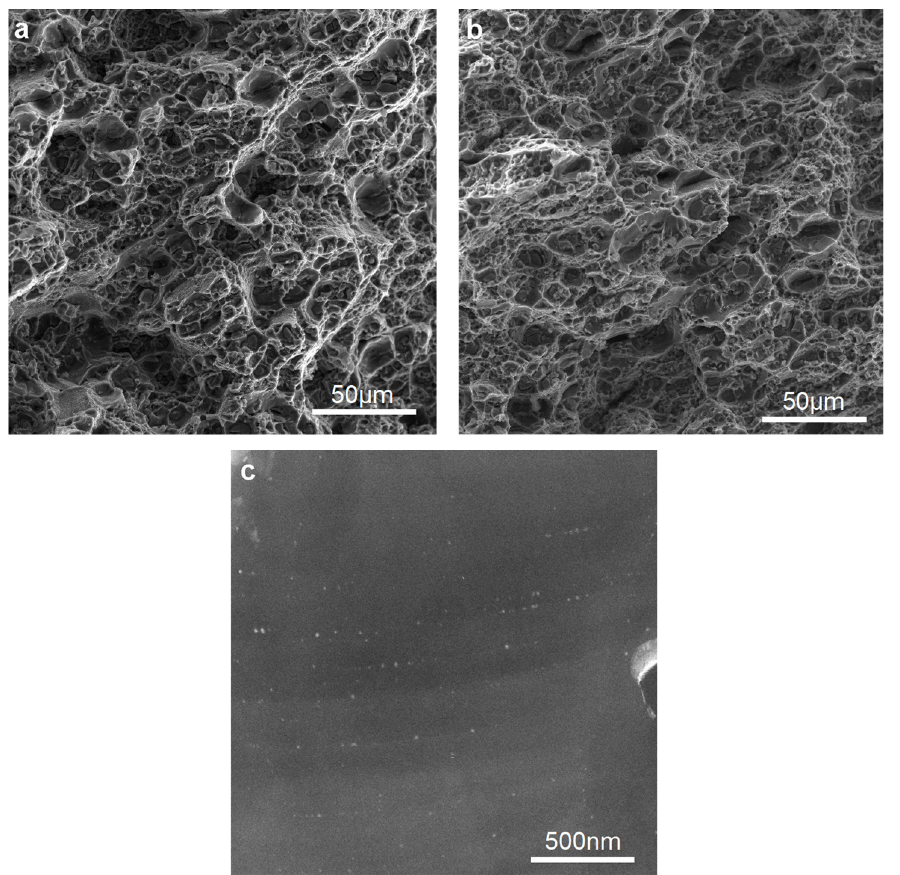
Figure 12. Dimples on the fracture surface in the specimen under thermomechanical treatment with controlled quenching and ( a ) 30% rolling, and ( b ) 50% rolling; ( c ) nano-precipitates at the end of dimples.